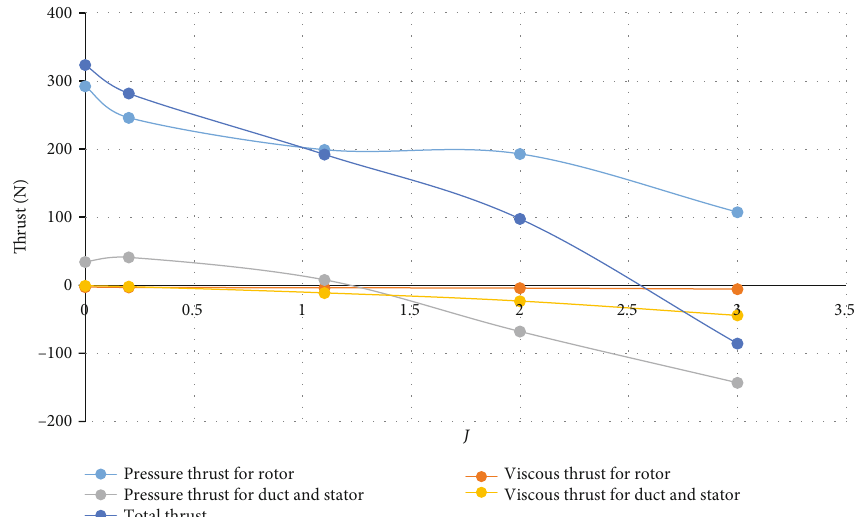
Figure 9: Thrust force calculated for the linear jet system with a stator.